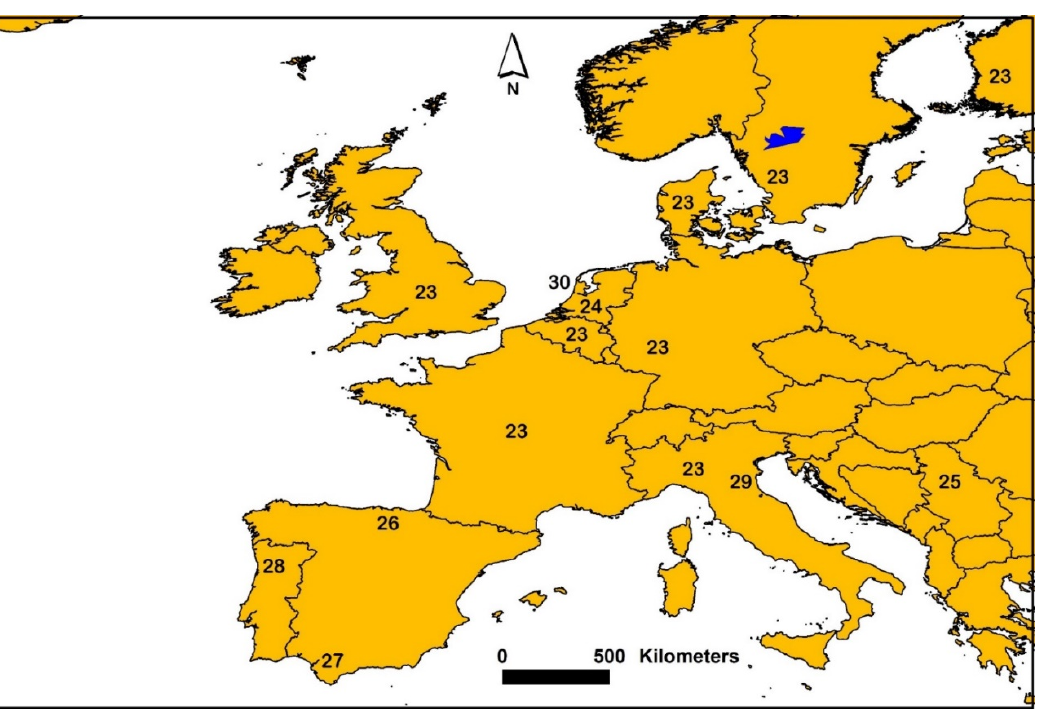
Figure 2. Map showing generalized locations where sediment AVS was sampled from various studies in Europe. Number symbols on the map are associated with individual or multiple studies and references. The following numbers and associated references are: 23 [1], 24 [22,23], 25 [33], 26 [30], 27 [46,47], 28 [61], 29 [64] and 30 [23].